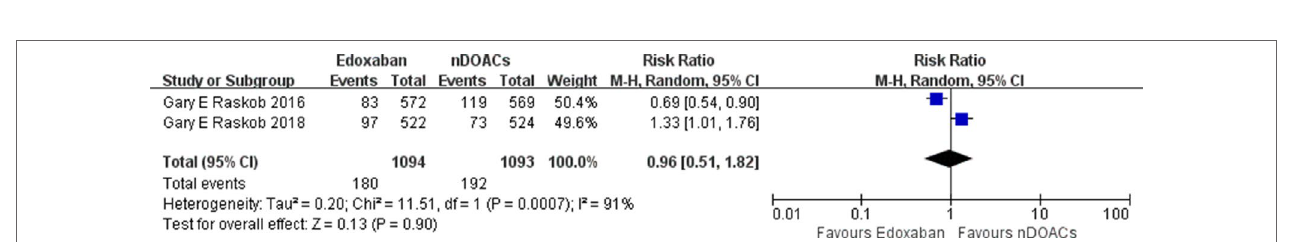
FIGURE 9 | Edoxaban MB or CRNMB forest